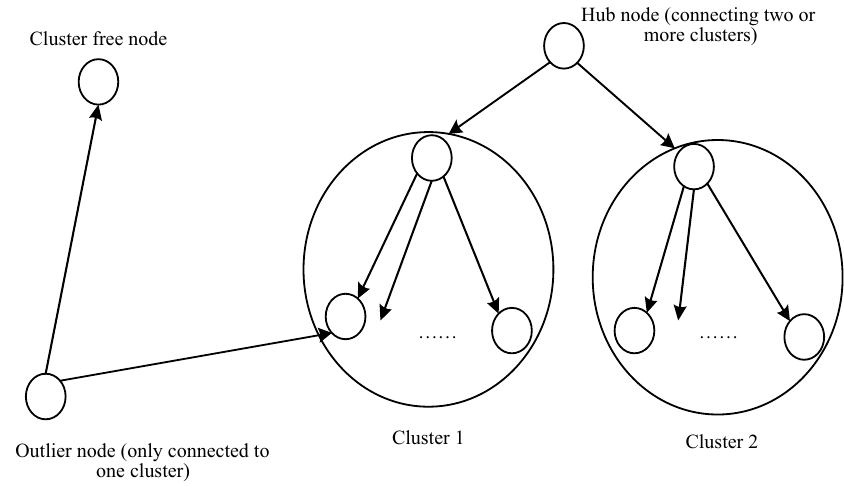
Figure 3: Distribution map of the cluster center and other cluster